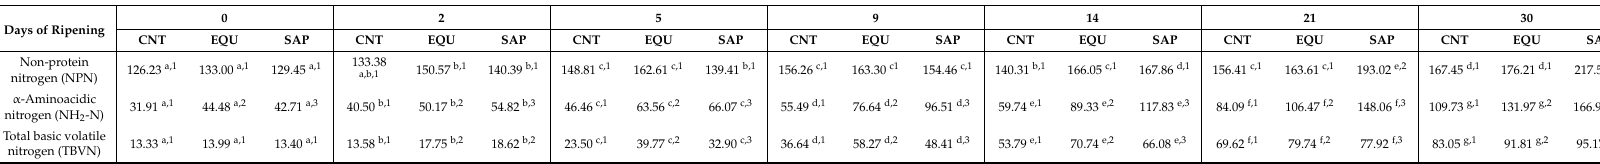
Table 4. Evolution of the nitrogen fractions (expressed as mg N / 100 g TS) along the manufacturing process of Galician chorizo made without and with starter cultures (means of three replicates in each sausage